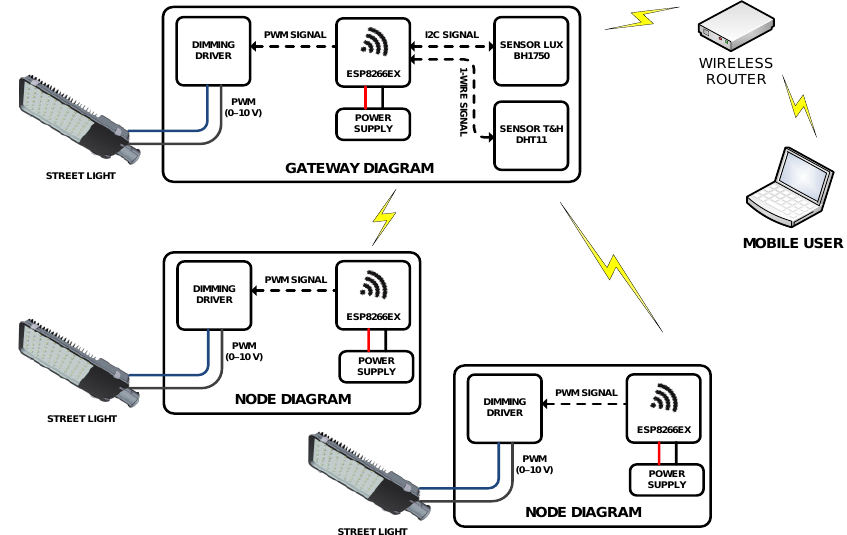
Fig. 1. Block diagram of control